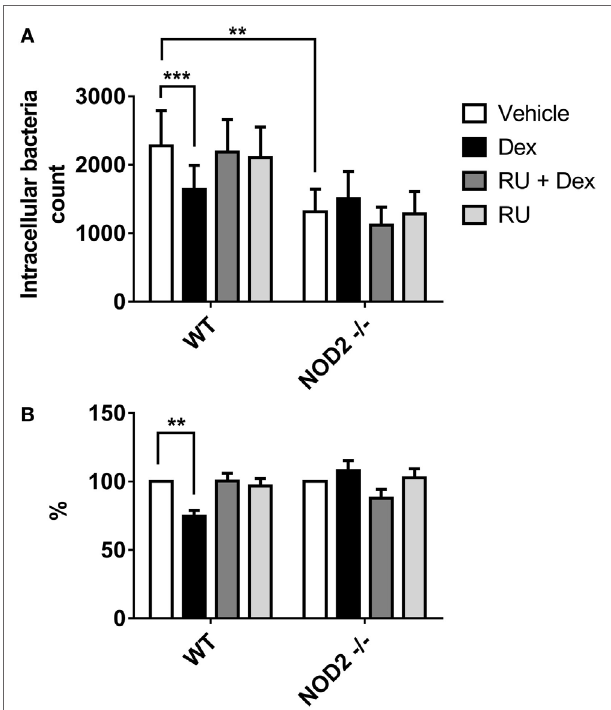
FigUre 7 | Dexamethasone decreases phagocytosis of murine macrophages against CD2-a Escherichia coli strain, but not on Nod2 − / − . Wild type (WT) and Nod2 − / − macrophages treated with 100 nM Dex for 24 h were infected with E. coli strains (multiplicity of infection: 10). Amikacin protection assay was performed 30 min after infection to evaluate phagocytic levels. (a) Absolute intracellular CFU count. (B) Normalization to vehicle. Two- way ANOVA and Dunnet corrections were performed ( n = 5; *** p < 0.001 compared to vehicle). Student’s t -test was performed to compare absolute numbers between WT and Nod2 − / − ( n = 5; ** p <